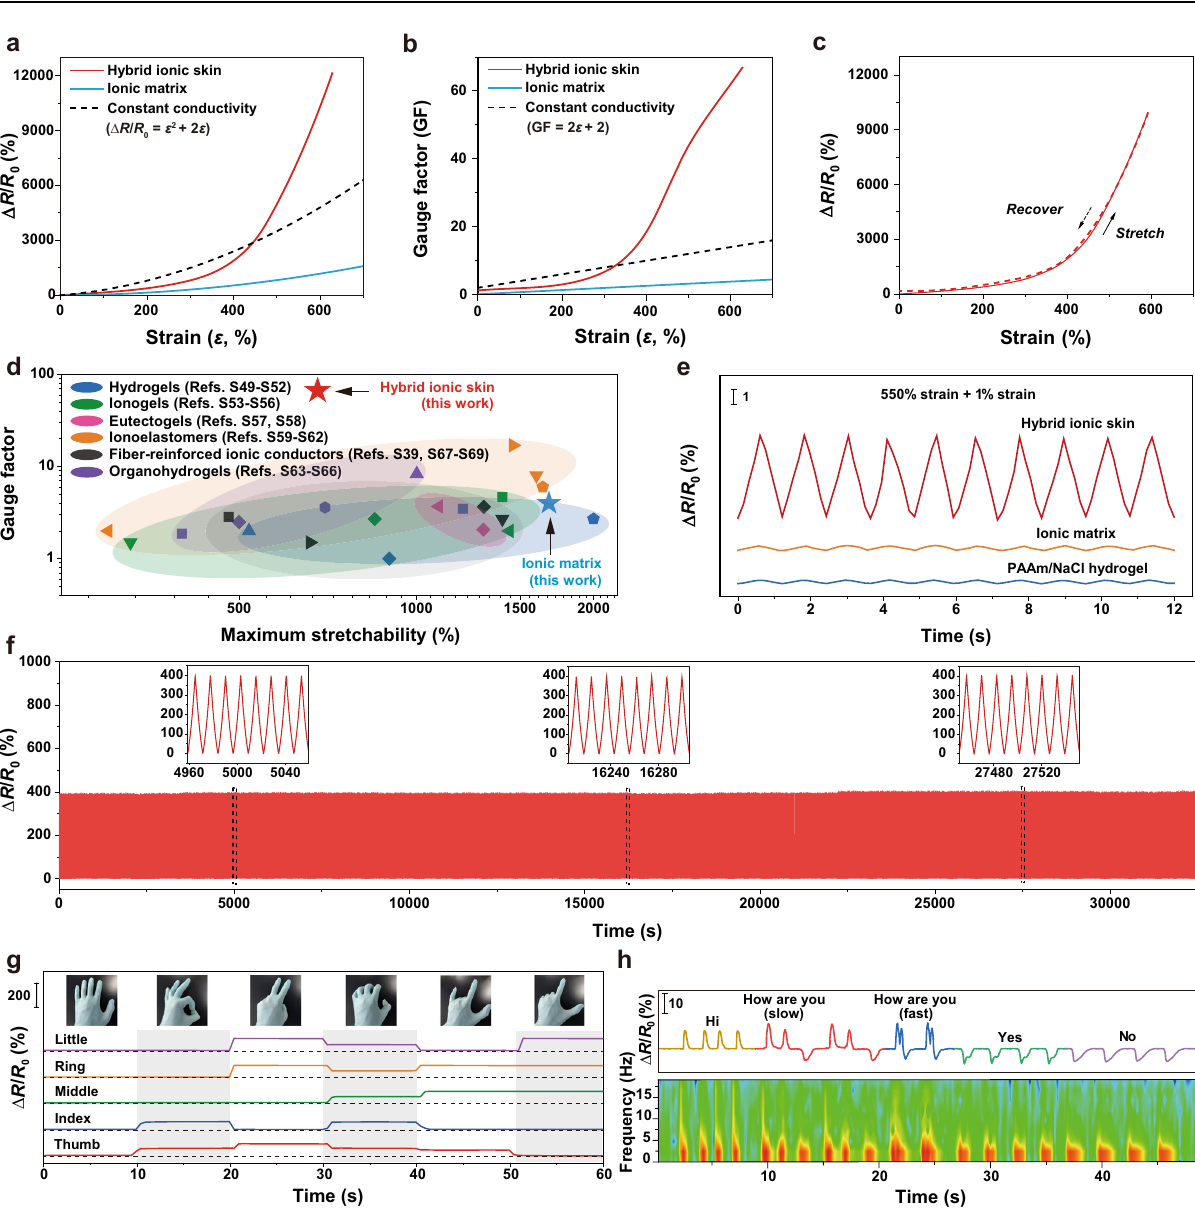
ionic skin, ionic matrix, and PAAm/NaCl hydrogel by superimposing 1% strain on fi xed550%strain. f Real-timeresponsebystretchingto200%strainfor2500cycles. g Multichannelmonitoring ofgestures with fi ve adhered hybrid ionic skin sensors. h Voice recognition with an attached hybrid ionic skin sensor on a volunteer ’ s throat. Source data are provided as a Source Data fi